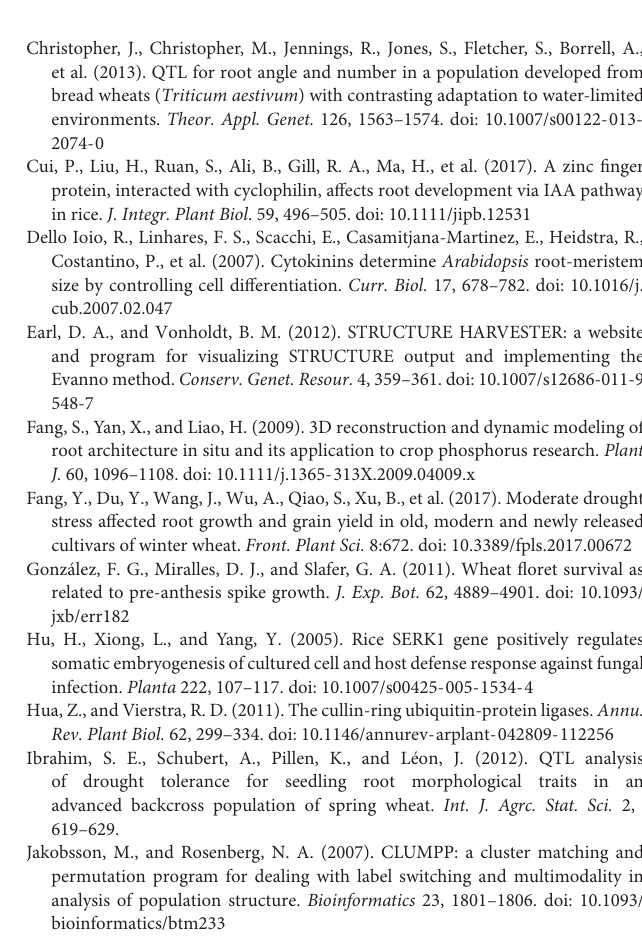
Supplementary Table 8 | The expression data (fragments per kilobase of transcript per million reads sequenced, FPKM) in different organs at different